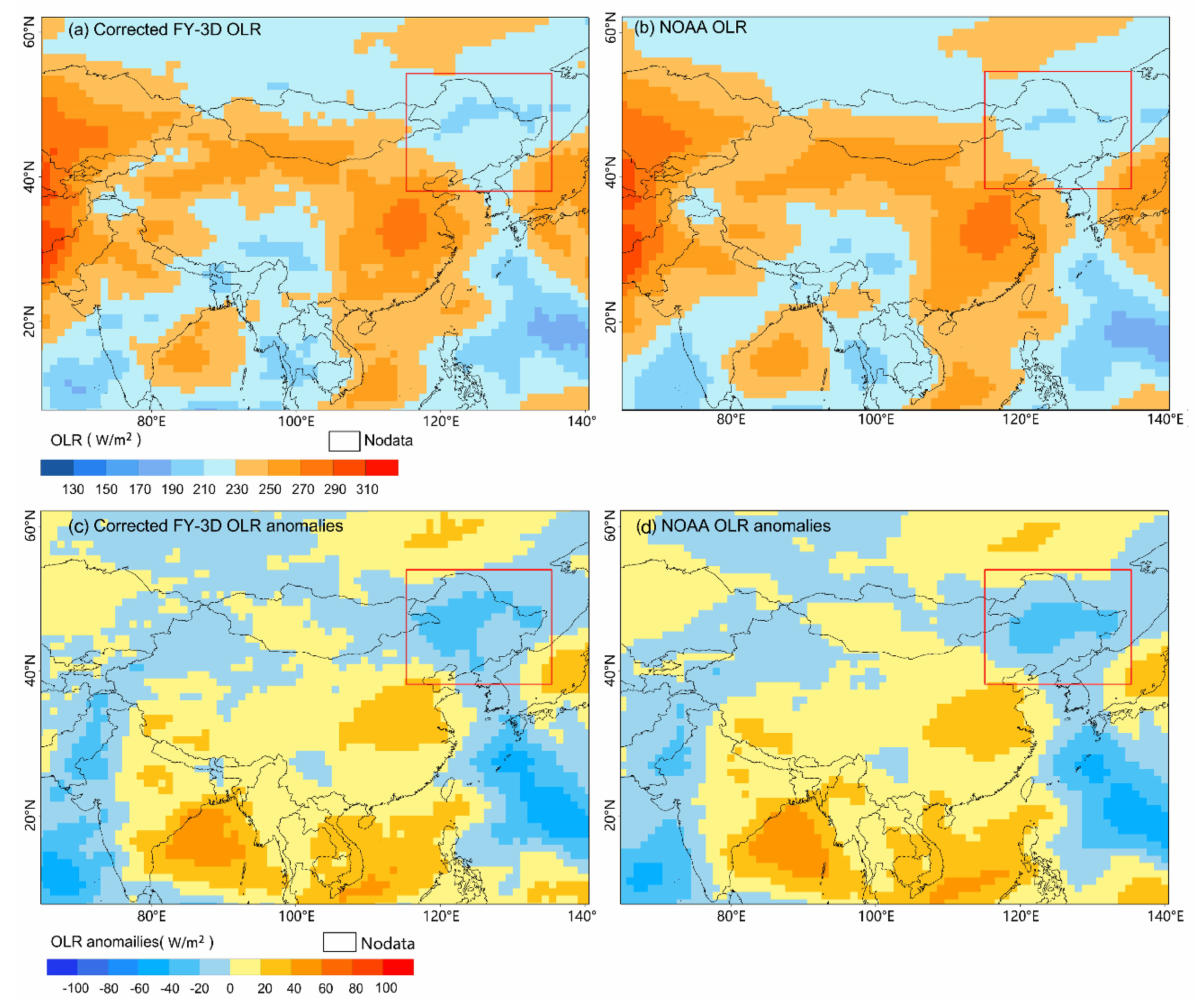
Figure 9. Actual and abnormal distributions of the corrected F _OLR ( a , c ) and N _OLR ( b , d ) during typhoon precipitation (27 August–7 September 2020) in China. The red box marks the region of 118 ◦ –135 ◦ E, 38 ◦ –54 ◦